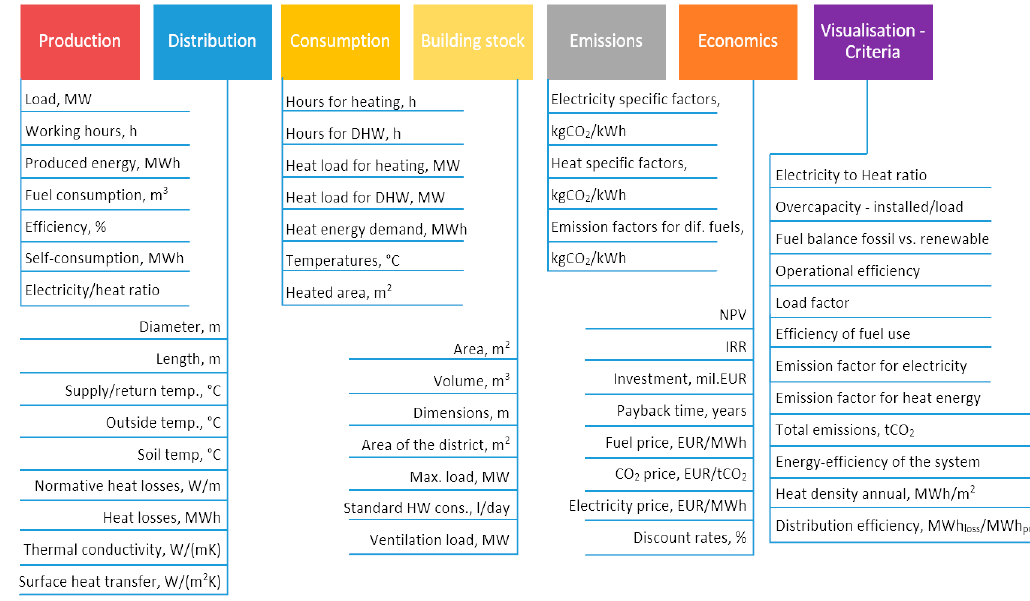
Figure 1. Smart District Heating Planning Tool overview.